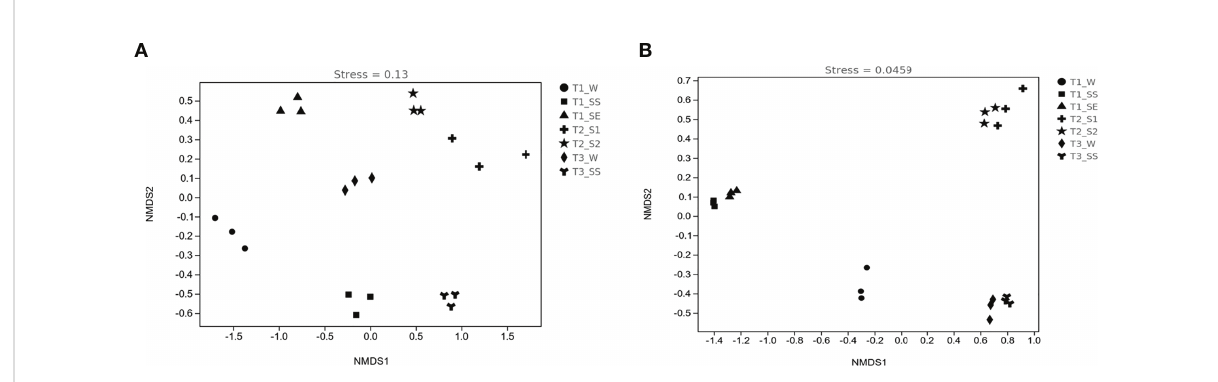
FIGURE 9 Nonmetric multidimensional scaling (NMDS) ordinations of bacterial (A) and fungal (B) diversities in soils belonging to different water-repellency classes beneath Pinus (T 1 ), Robinia (T 2 ), and Hippophae (T 3